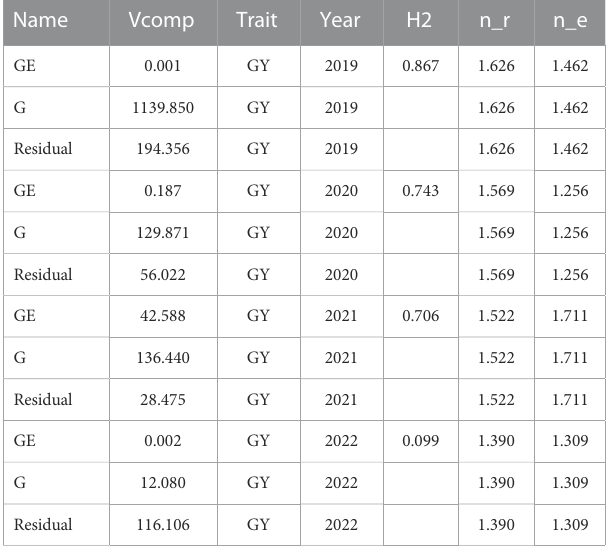
TABLE 2 Heritability estimates (H2) of grain yield (GY) in each of the 4 years and variance components (Vcomp) for the genotypes (G), genotype by environment interaction (GE) and Residual, n_e denotes the average number oflocations,n_rdenotestheaveragenumberofreplicationsofeachgenotype. Year is the column to differentiate each data